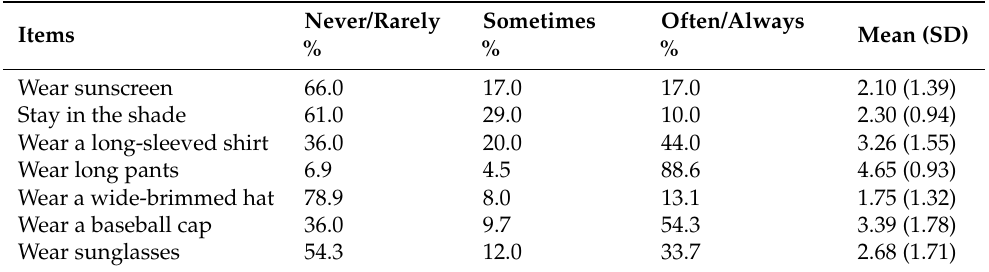
Table 5. Sun protection behaviors when working outside on warm, sunny days last